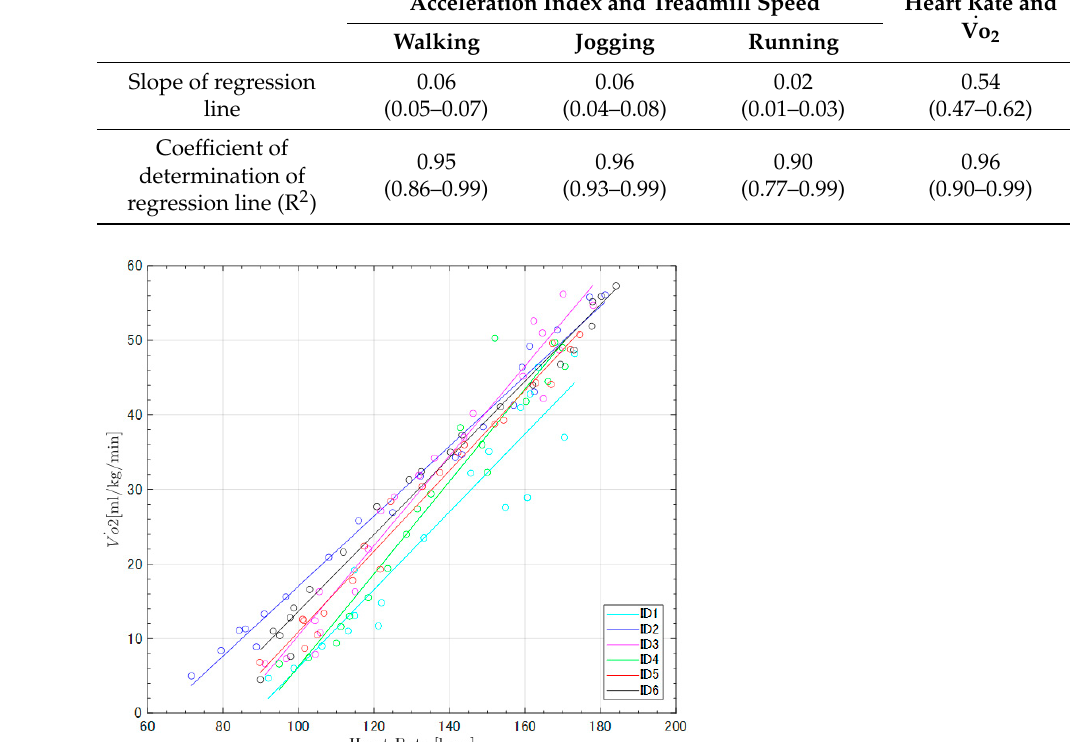
Table 1. Slope of regression lines and coefficient of determination.